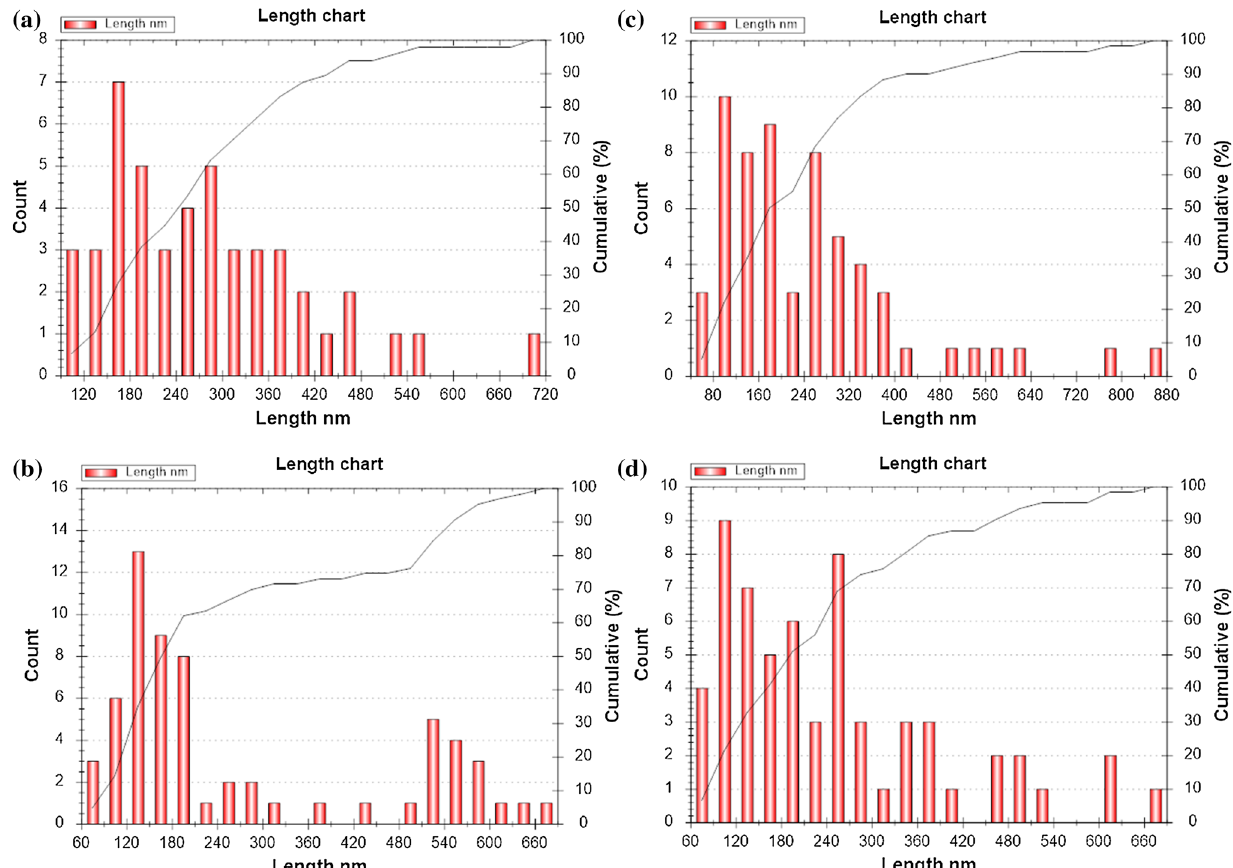
Fig. 3 Results of image analysis of the SEM images of a BMM, b MN, c MT and d MN50T50